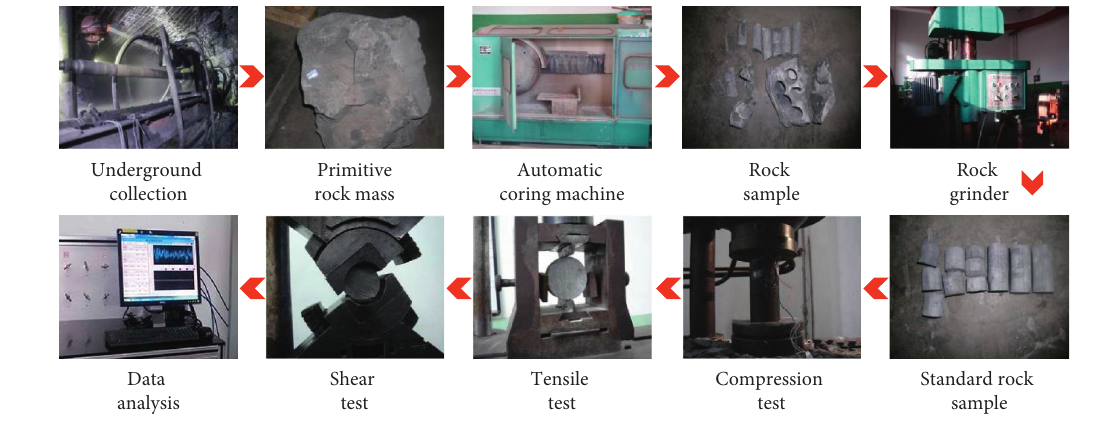
Figure 2: The experimental process. Table 1: The physical and mechanical properties of roadway surrounding